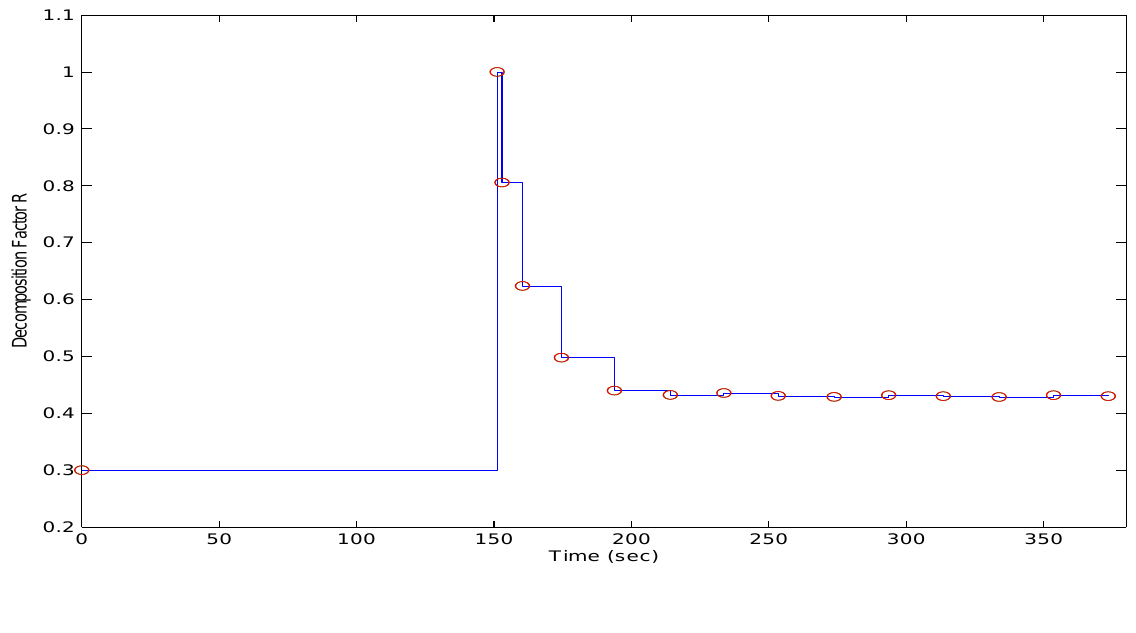
Figure 16 . QT–Decomposition factor R convergence over experimental time (Initial values R = 0 : 9 , T d = 10 s, and (cid:22) = 0 : 01 ).